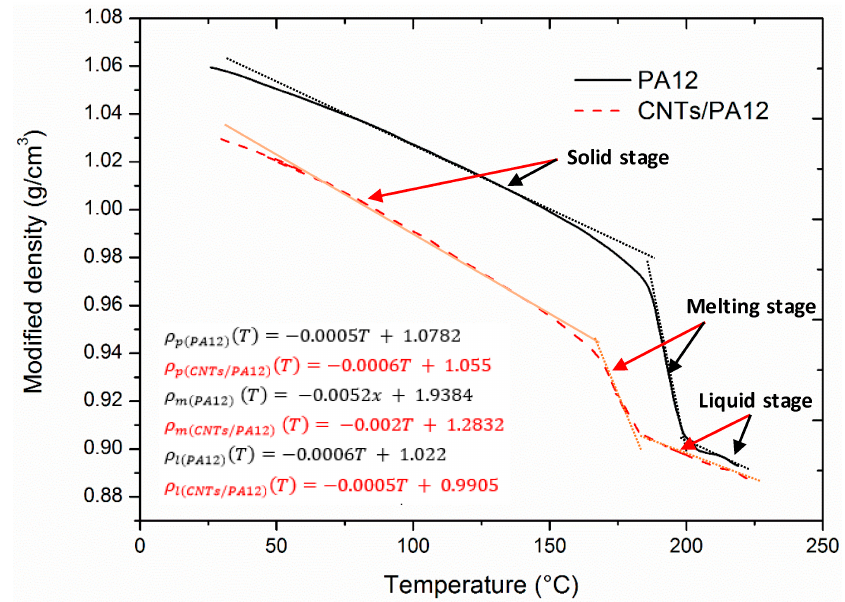
Figure 5. Increasing temperature from 25 to 225 °C, the modified densities of PA12 and CNTs/PA12 exhibit linear relationships with temperature in three stages via the solid, melting and liquid state.